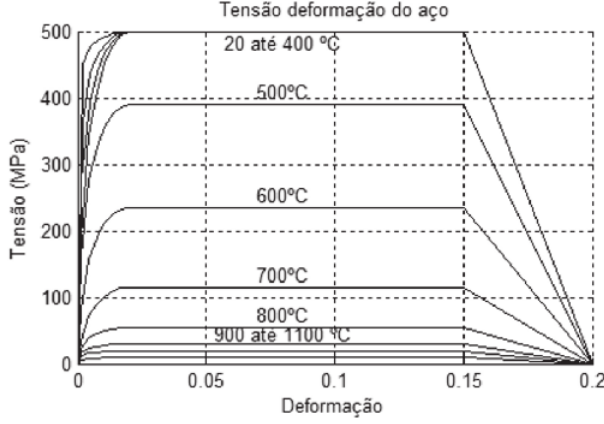
Figura 13 Diagrama tensão-deformação do aço variando com a temperatura